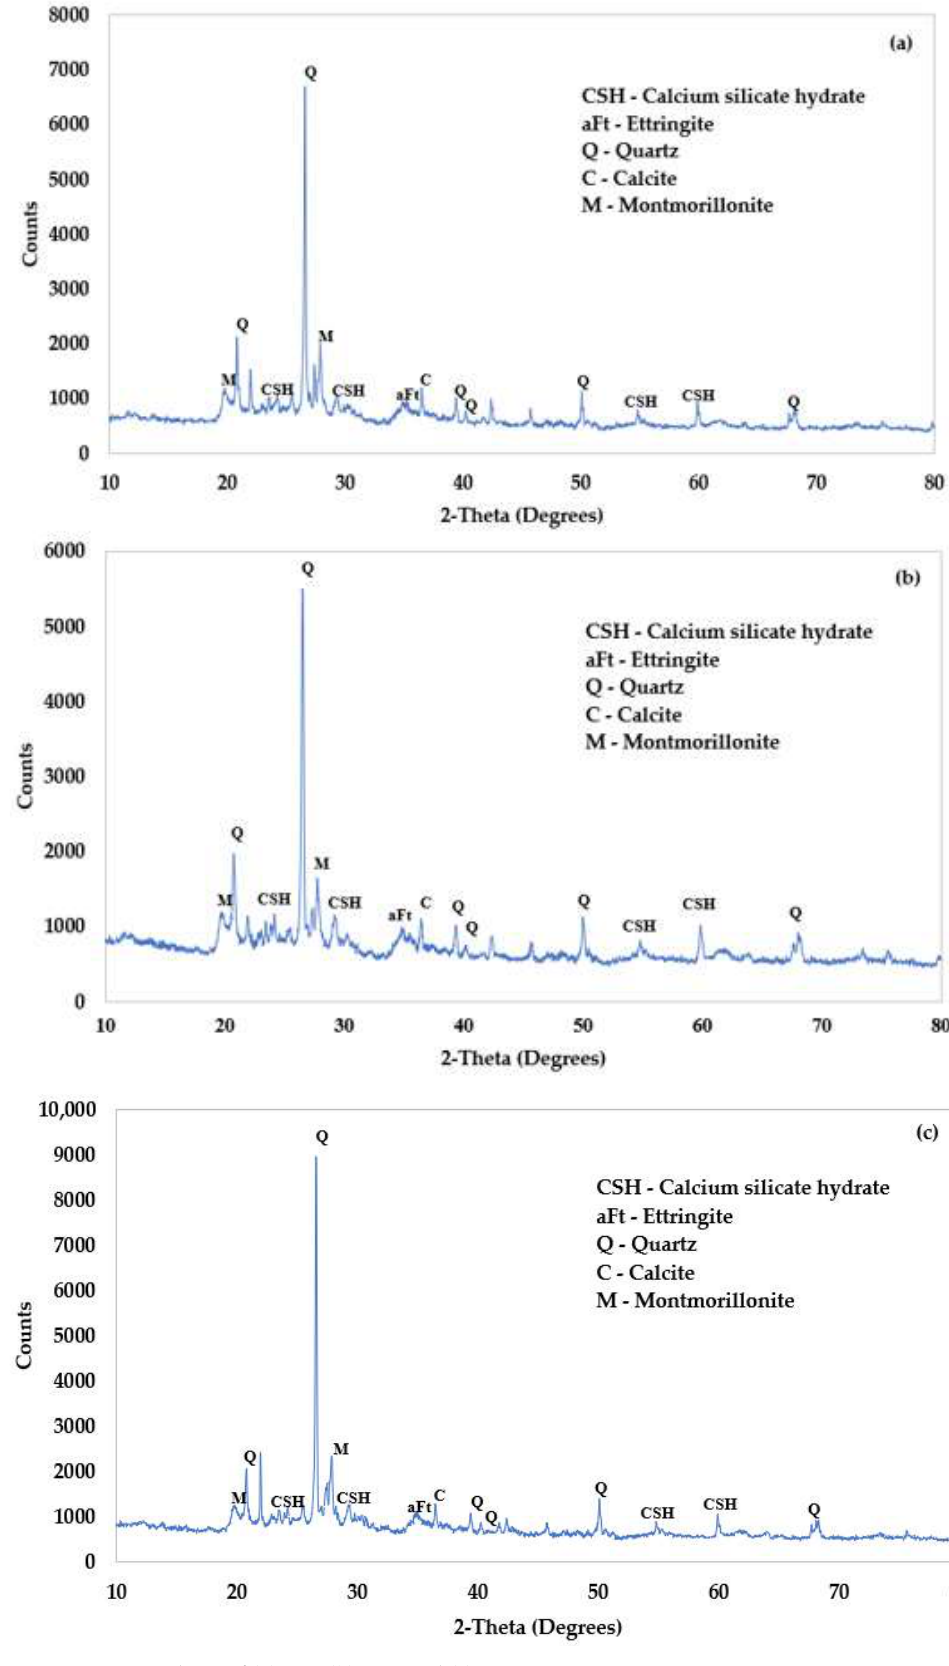
Figure 6. Mineralogy of ( a ) LP1 ( b ) LP2 and ( c ) LP3.